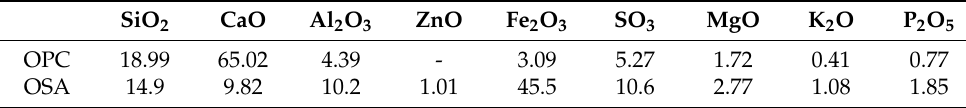
Figure 4. Oily sludge ash ( A ) XRD pattern and ( B ) FESEM image. Table 5. Chemical composition of OPC and